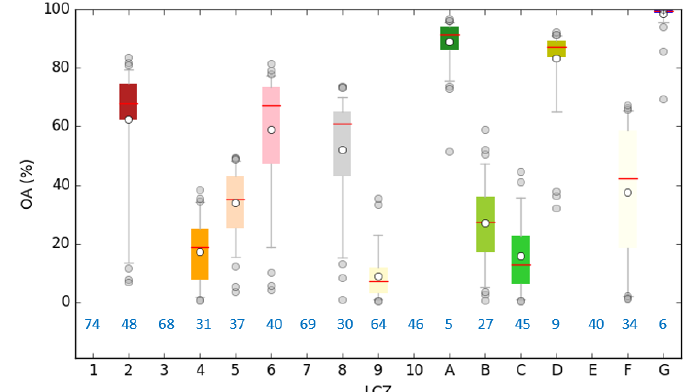
Figure 8. Boxplots for the F1 score for each LCZ after the last iteration, blue values = number of times a participant indicated this zone as difficult to classify over all iterations. Median OA: red stripe; average OA: white dot; boxplot ends: first and third quantile; whiskers: + / − the 1.5-fold interquartile range on OA values and outliers: grey dots. The colour of the boxplots are the LCZ colours when the zones are